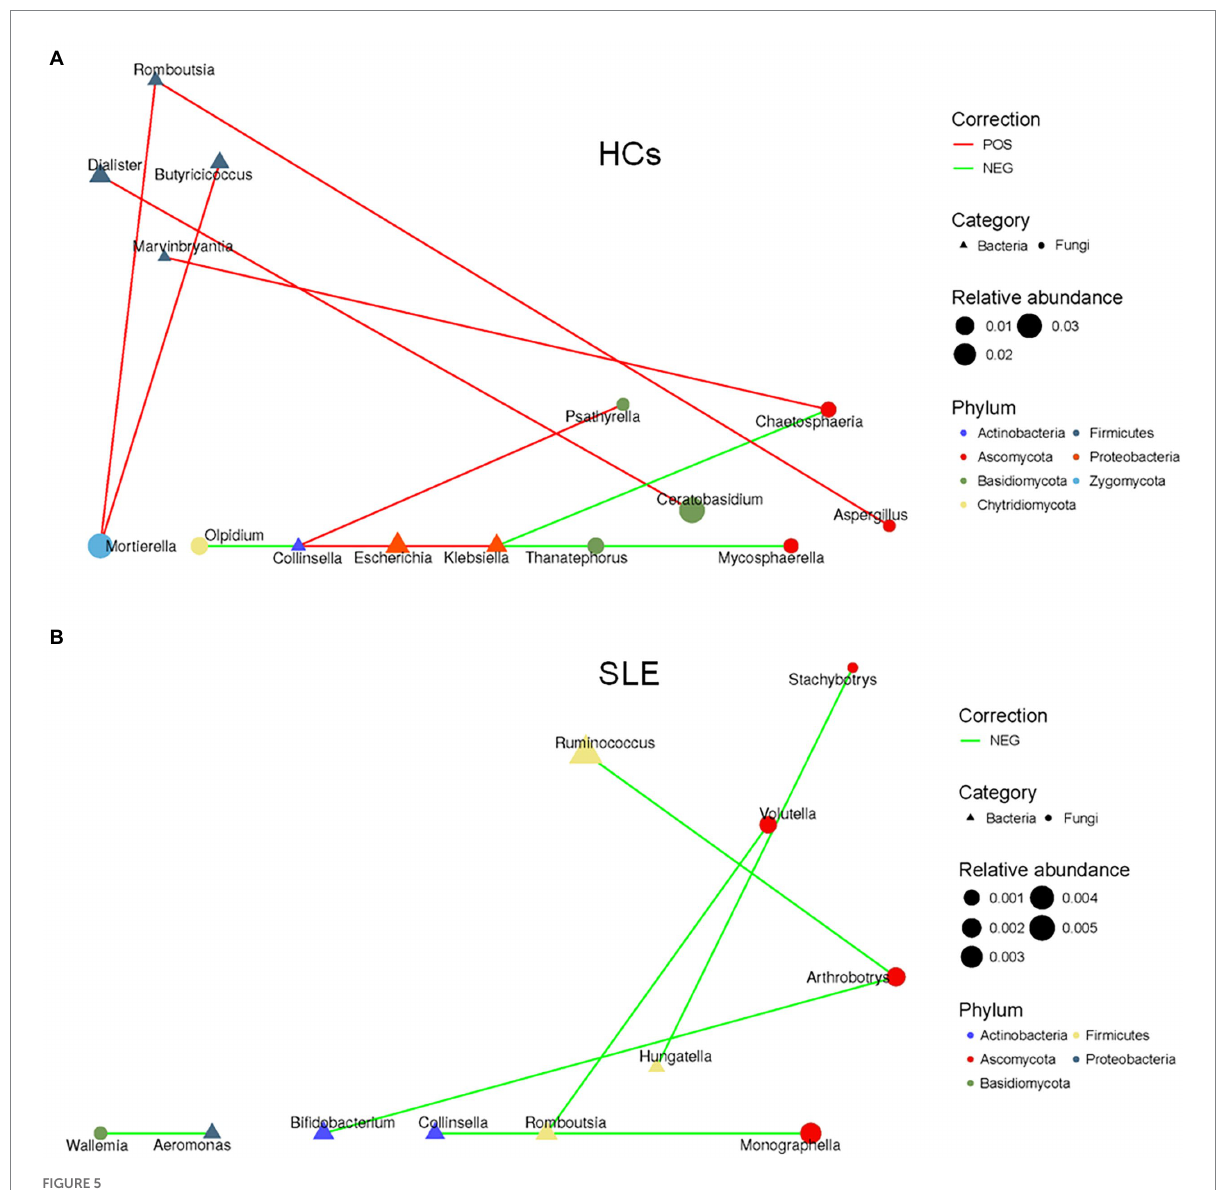
FIGURE 5 Altered bacterial-fungal associations between SLE and HCs. (A) The bacterial-fungal association network at the genus level in HCs; (B) the bacterial-fungal association network at the genus level in